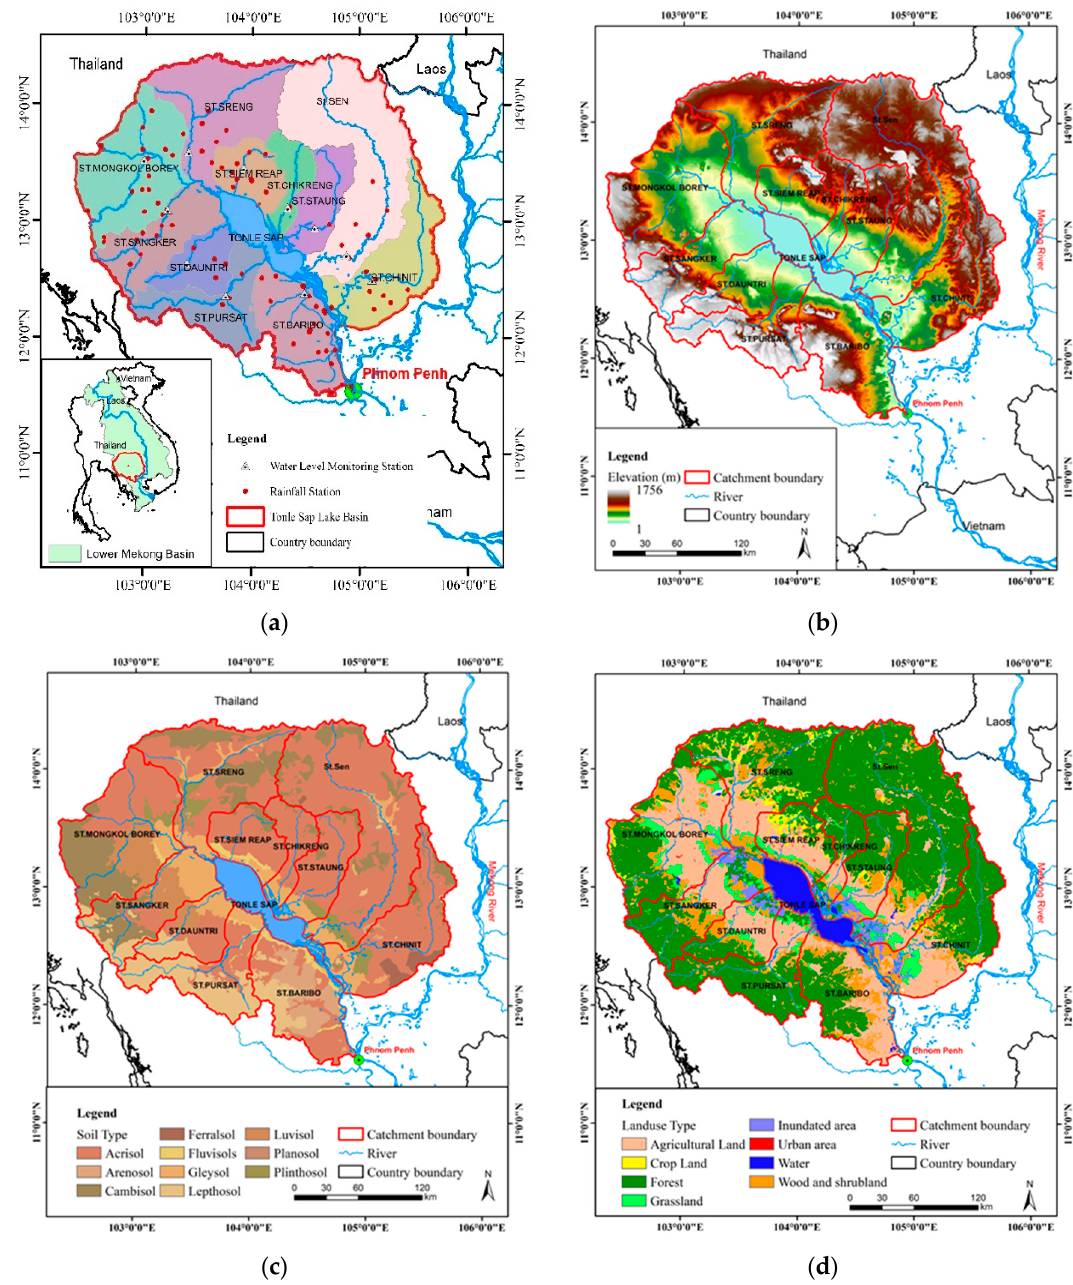
Figure 1. ( a ) Study area with water level monitoring and rainfall stations, ( b ) digital elevation model, ( c ) soil type and ( d ) land use/land cover of Tonle Sap Lake Basin.